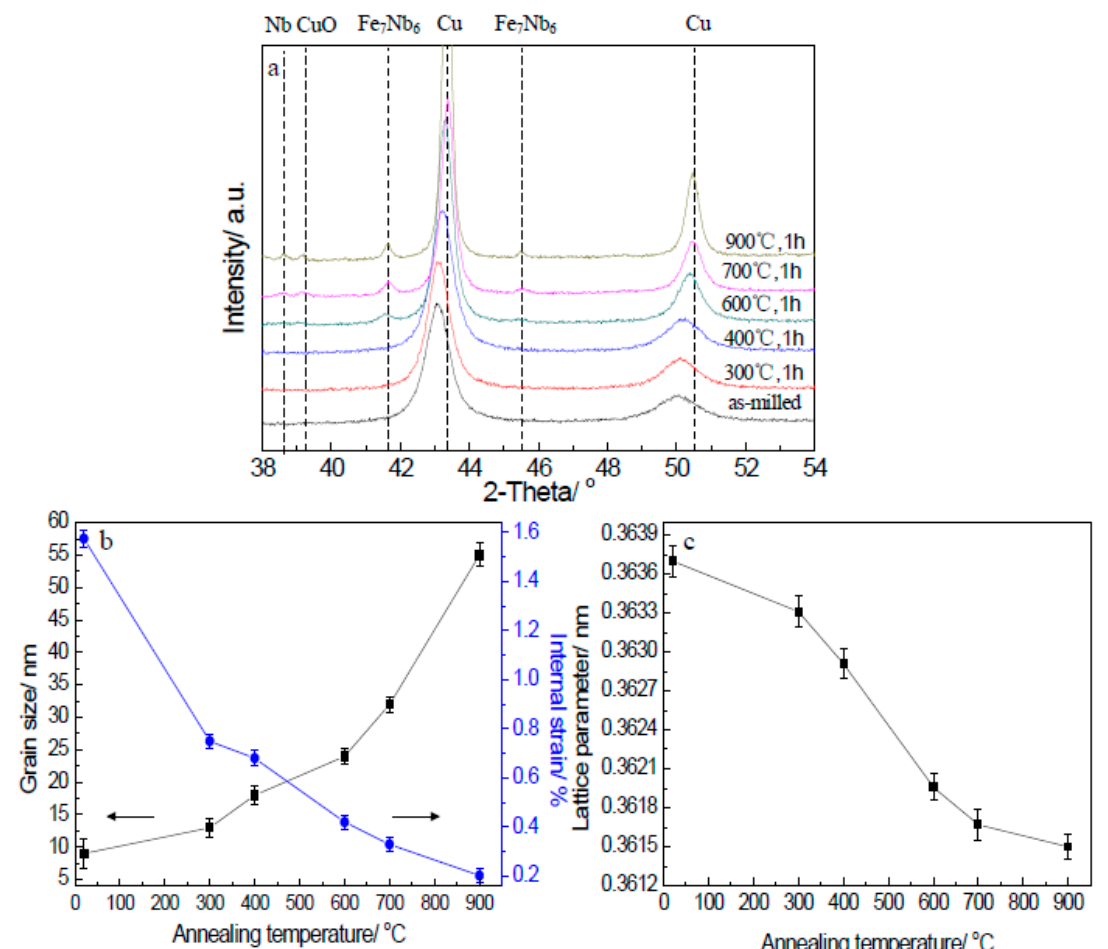
Figure 1. XRD results of MA-ed Cu-Nb powders after annealing at different temperatures for 1 h. ( a ) XRD patterns of annealed samples; ( b ) Mean crystalline grain size (indicated by left arrow) and internal strain of Cu phase (indicated by right arrow) with respect to annealing temperatures; ( c ) Cu lattice parameter as a function of annealing temperatures.